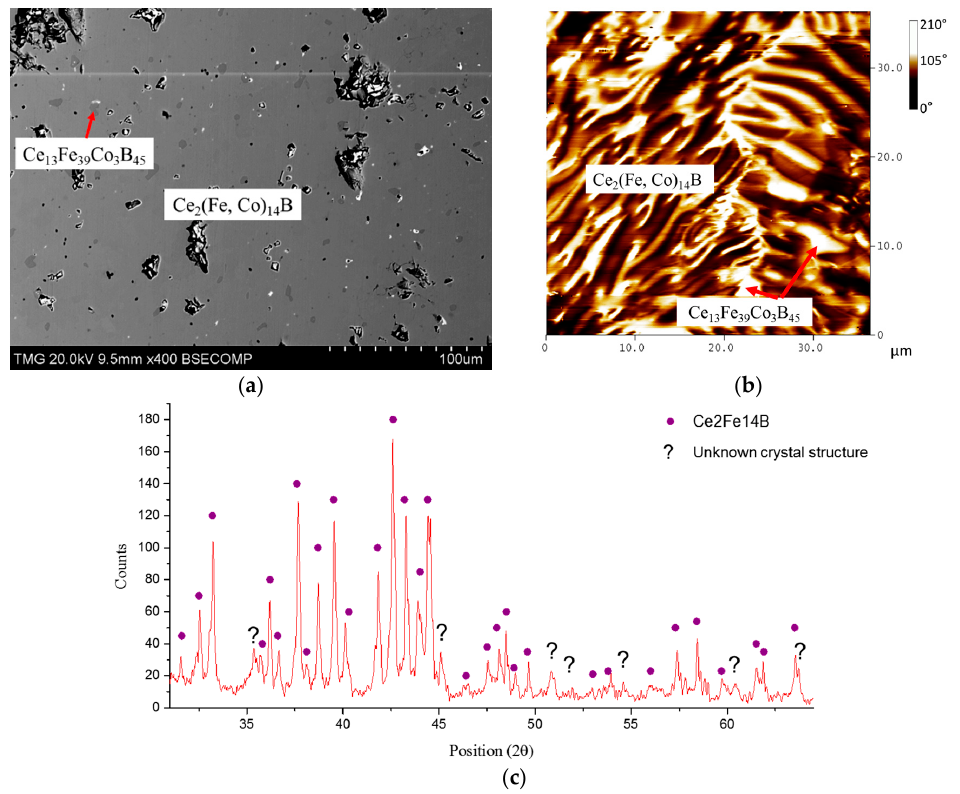
Figure 12. ( a ) BSE image of KA 1; ( b ) MFM image of KA 1; ( c ) XRD spectrum of KA 1. When the concentration of Co in the global composition increased from 7 at. % in KA 1–12 at. % in KA 2, three-phase equilibrium between Ce 2 (Fe, Co) 14 B, Ce(Co, Fe) 4 B, and CeFeCo occurred, as shown in Figure 13a. Unlike in KA 1, the boron-rich phase is not observed in KA 2. Instead, a limited